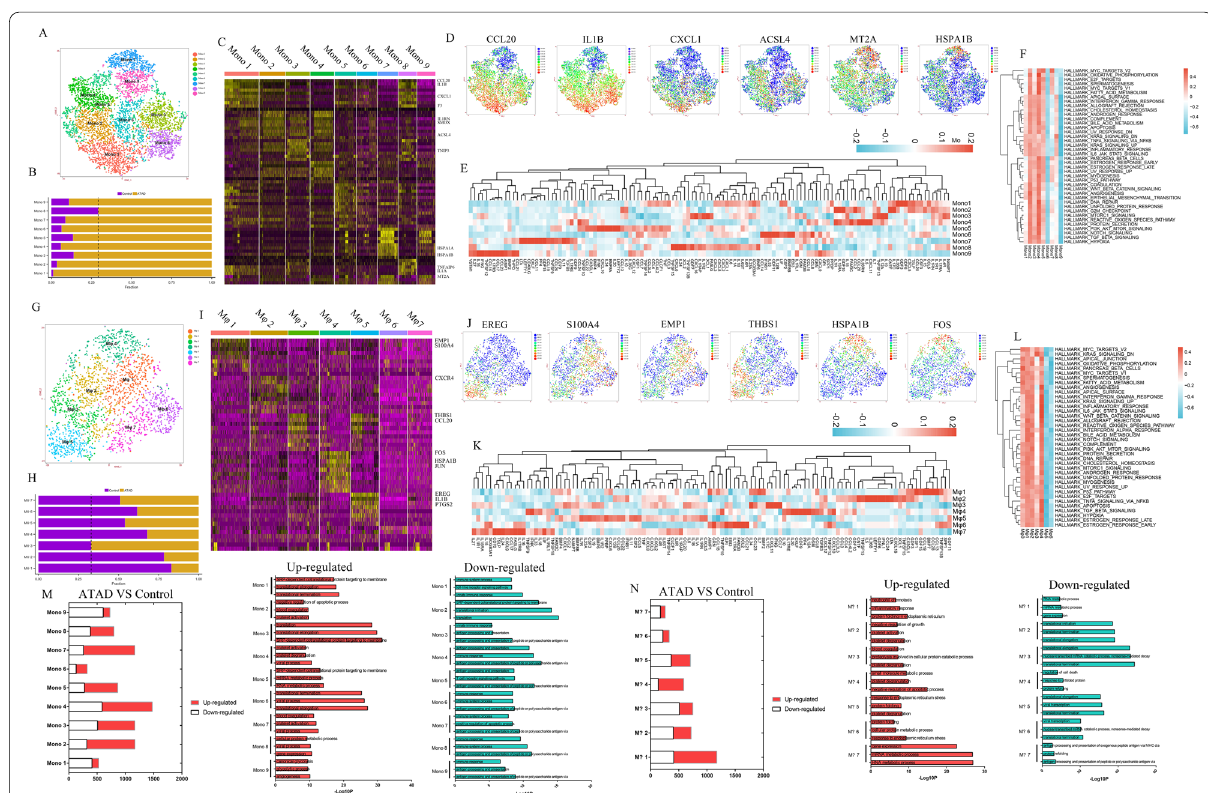
Fig. 5 Nine subpopulations of monocytes and 7 subpopulations of macrophages were identified with different markers and functions. A t‑SNE plot showed 9 subpopulations of monocytes upon re‑clustering. B the proportion for each subpopulation of monocytes between control and ATAD group. The dashed line represented the highest proportion of Mono 8 in control group. C heatmap of marker genes for each subpopulation of monocytes. D t‑SNE plots showed the expressions of representative marker genes for each subpopulation of monocytes. E Qusage analysis of hallmark gene‑sets enrichment for subpopulations of monocytes. F the expressions of cytokines for subpopulations of monocytes. G t‑SNE plot exhibited 7 subpopulations of macrophages. H The proportion for each subpopulation of macrophages between control and ATAD group. The dashed line was used to discriminate the dominant subpopulations in ATAD and control group. I Heatmap of marker genes for each subpopulation of macrophages. J t‑SNE plots revealed the expressions of representative marker genes for each subpopulation of macrophages. K Qusage analysis of hallmark gene‑sets enrichment for each subpopulation of macrophages. L the expressions of cytokines for subpopulations of macrophages. M DEGs and GO analysis for up‑regulated and down‑regulated genes in subpopulations of monocytes (ATAD/Control). N DEGs and GO analysis for up‑regulated and down‑regulated genes in subpopulations of macrophages